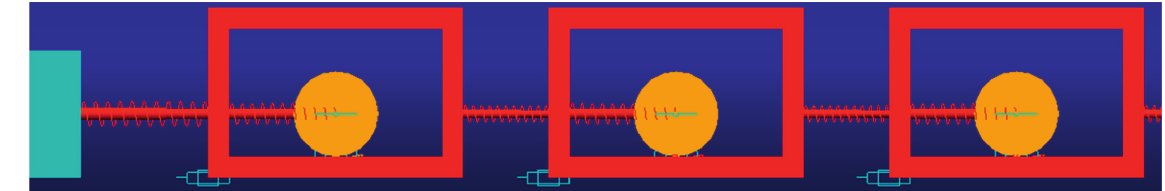
Figure 6: A schematic of the EMM arrangement of 1DOF model-MSC-ADAMS software.